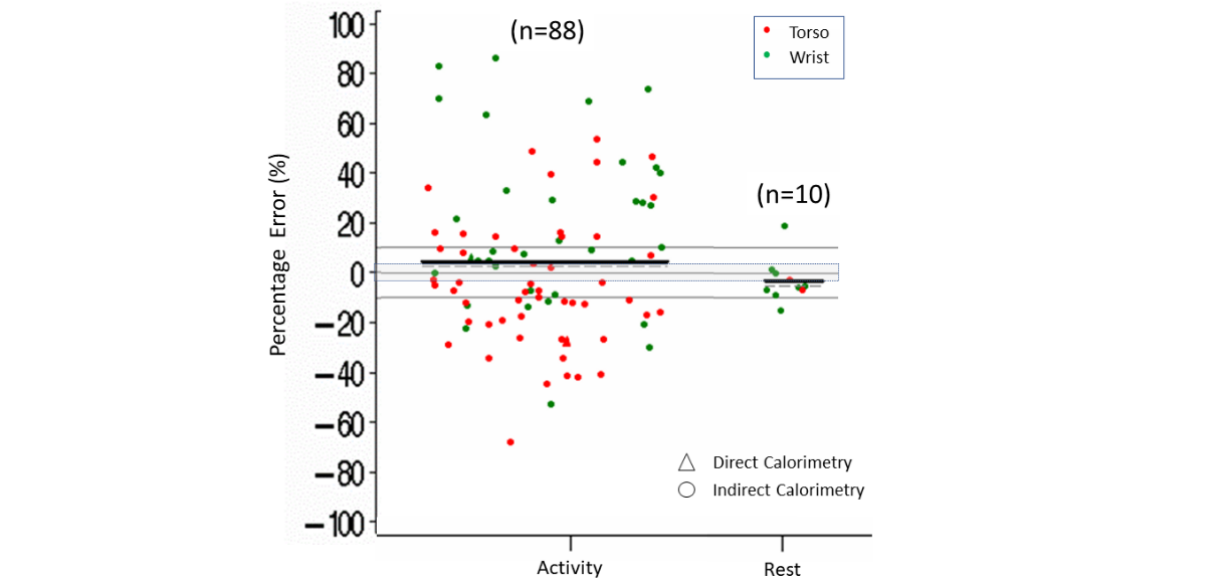
Figure 6. Energy expenditure percentage error in controlled settings. Activity versus rest by body placement (torso, wrist). Dark lines indicate mean (horizontal). Dashed lines indicate median (horizontal). Triangles indicate measurement by direct calorimetry. Gray shading indicates ±3% measurement